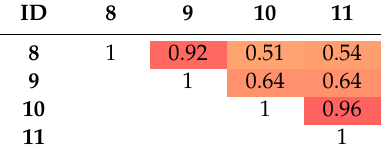
Table 4. Correlation table at study points in Cook Inlet based on the WY19